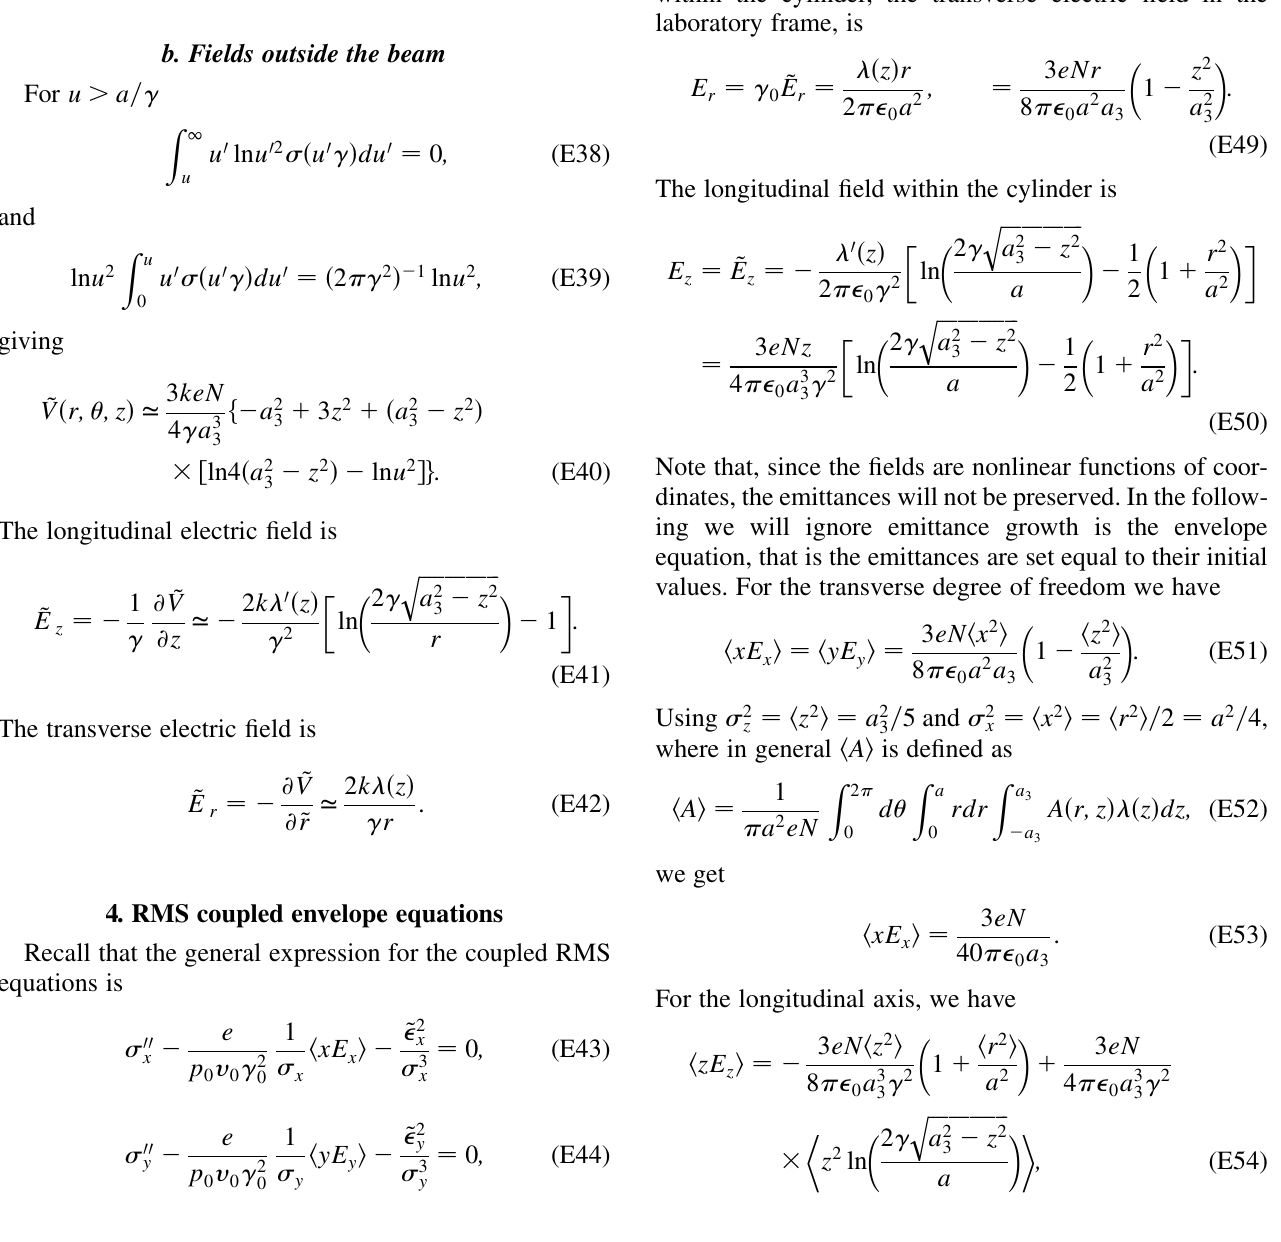
(cid:2) 0 ; (cid:13); z (cid:3) =E (cid:2) 0 ; (cid:13); z (cid:3) using a parabolic density profile FIG. 20. E (cid:15) z z (cid:1) 19 (cid:4) m , a (cid:1) 77 (cid:4) m , and (cid:7) [Eq. (E13)] and for a 0 3 E (cid:15) corresponds to the longitudinal electric field obtained from z direct integration of Eq. (E1). Recall that z (cid:1) 0 is the center of the